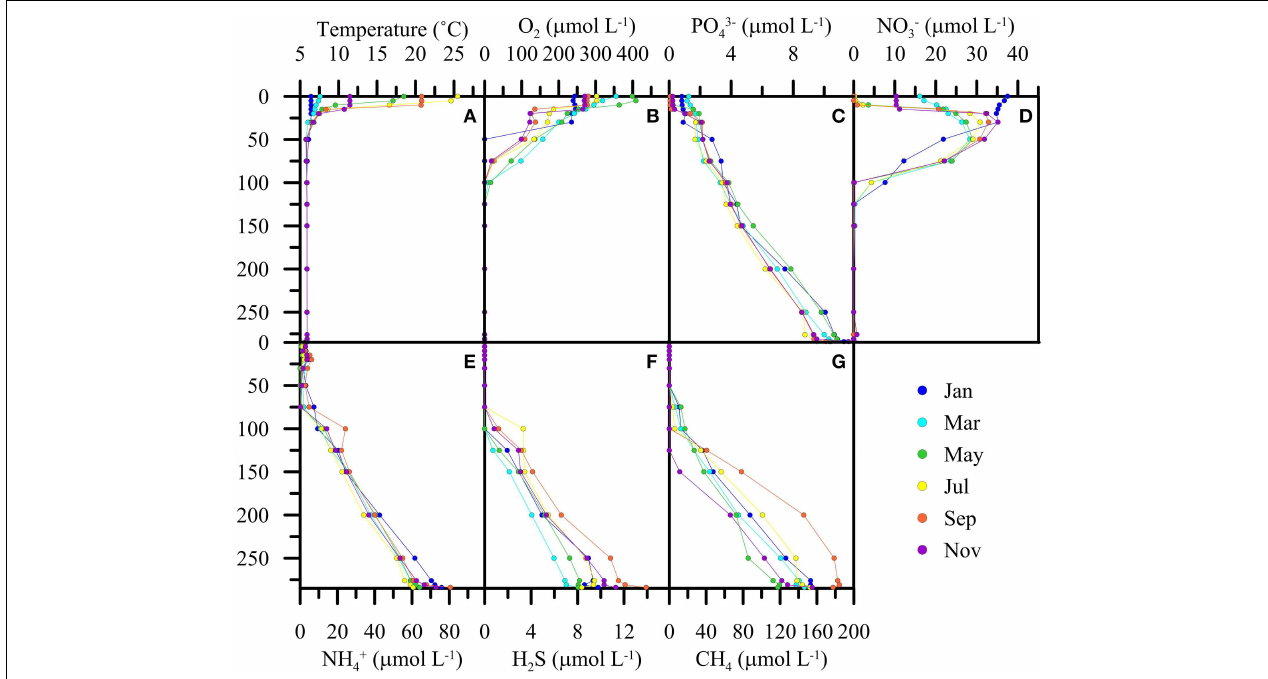
FIGURE 2 | Exemplary bi-monthly water-column profiles of temperature (A) and solute concentrations (B–G) during the seasonal cycle 2003.